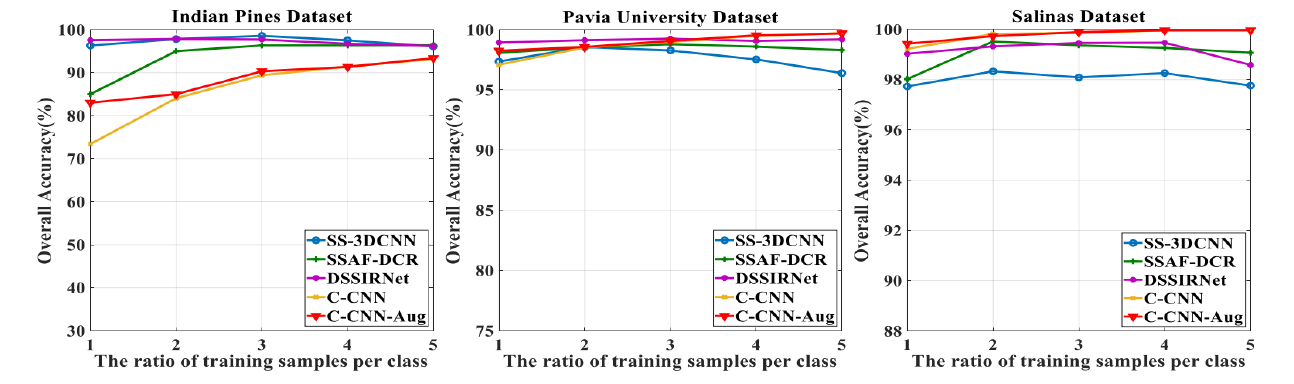
Figure 10. The overall accuracy performance comparison for different sample ratio of datasets and